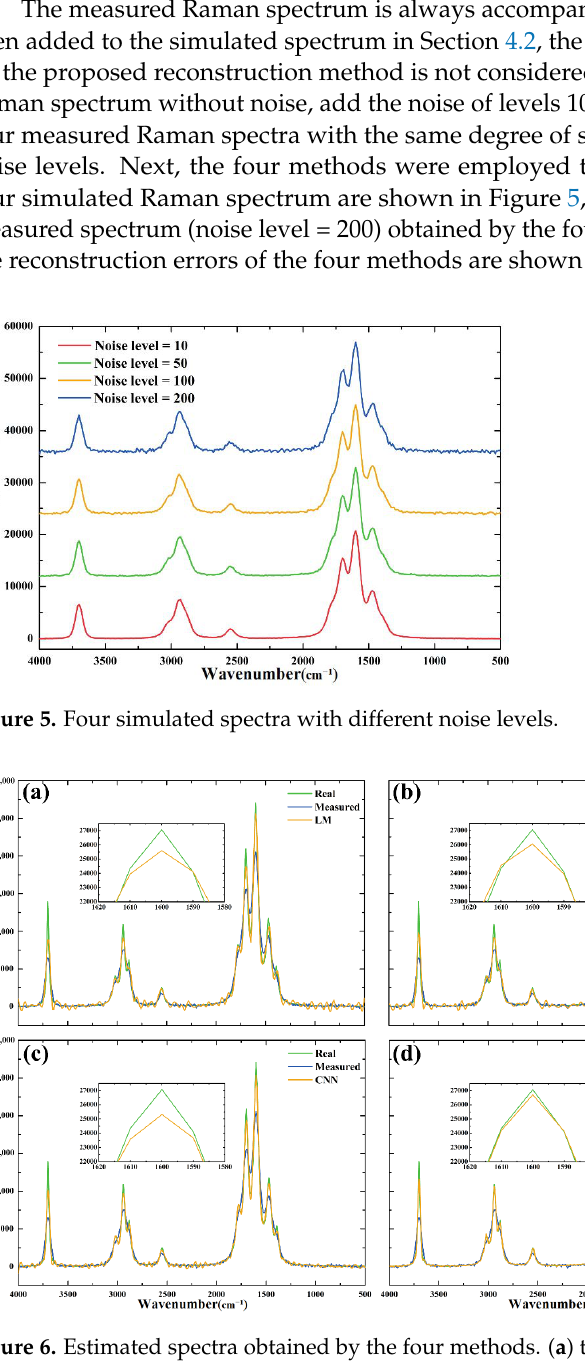
Figure 7. Reconstruction errors of the Raman spectrum by several methods. In Figure 6, the proposed method still shows an excellent reconstruction effect when the noise level is 200, as the reconstructed spectrum is essentially consistent with the real spectrum. Compared with the low noise situation, the estimated spectra obtained by the traditional methods have a greater degree of under correction, which is because these methods increase the regularization parameters to repress the noise. In addition, the esti- mated spectrum of the proposed method is smooth in the low-frequency regions, while